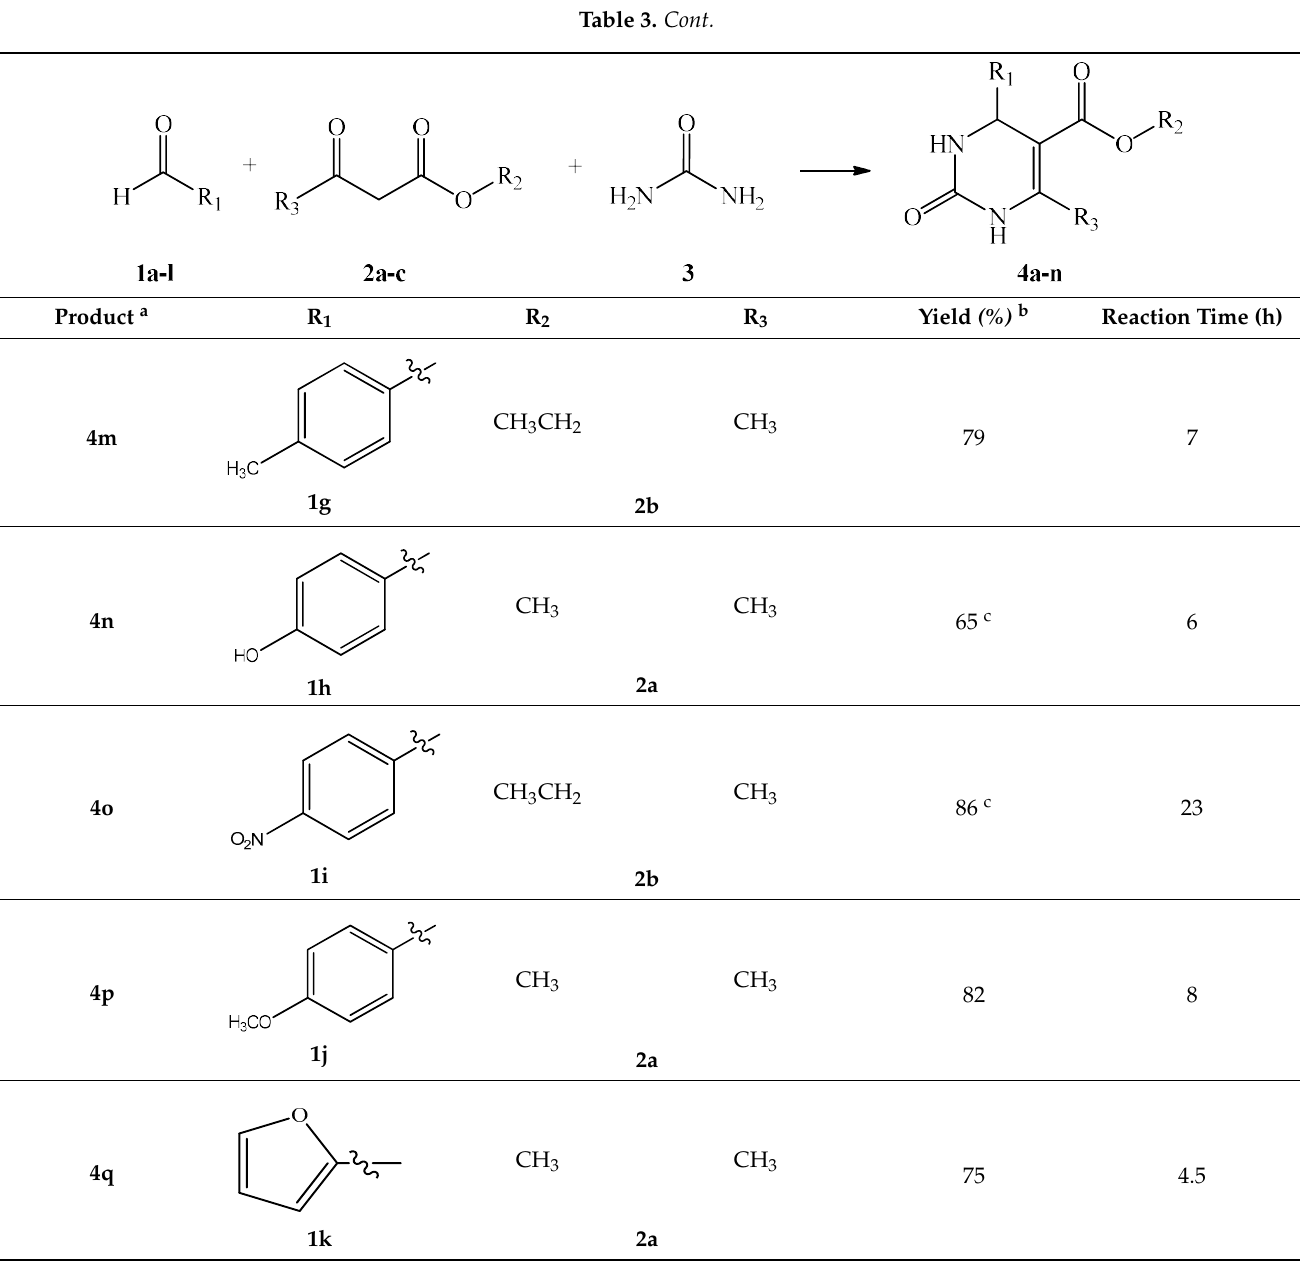
Table 3. Cont. Table 3. Yields and reaction times for the Biginelli reaction involving aldehydes ( 1a - l ), β-ketoesters ( 2a-c ) and urea ( 3